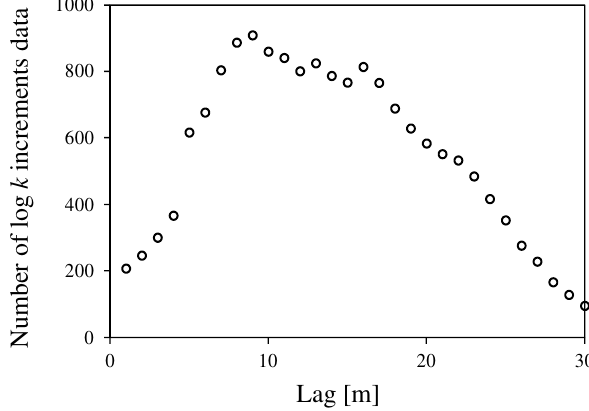
Fig. 5. Number of Arizona data pairs associated with each lag.